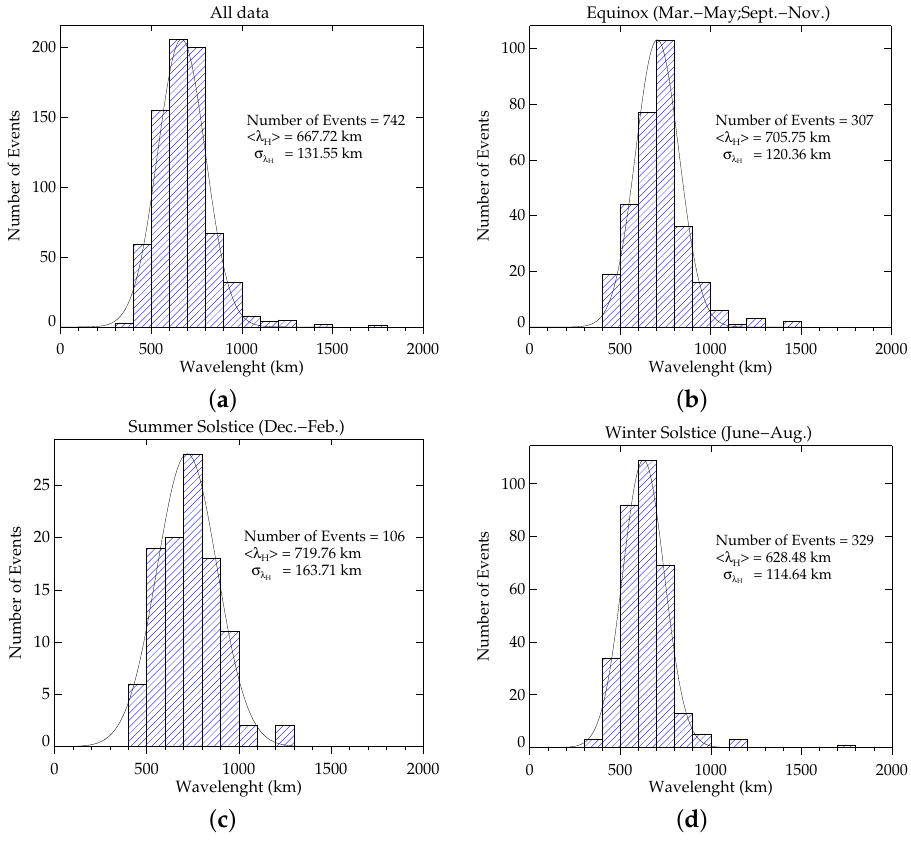
Figure 7. The horizontal wavelength distribution of the MSTIDs observed between January 2014 and December 2019 for ( a ) all seasons, ( b ) equinoxes, ( c ) summer, and ( d ) winter.